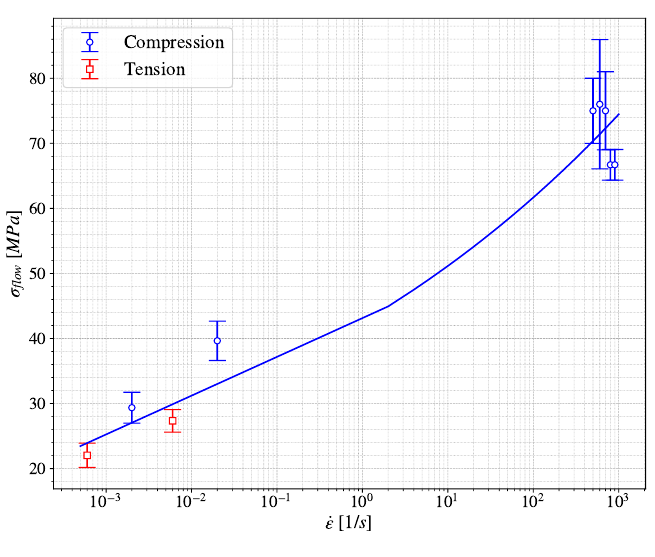
Figure 8. σ flow vs. ˙ ε